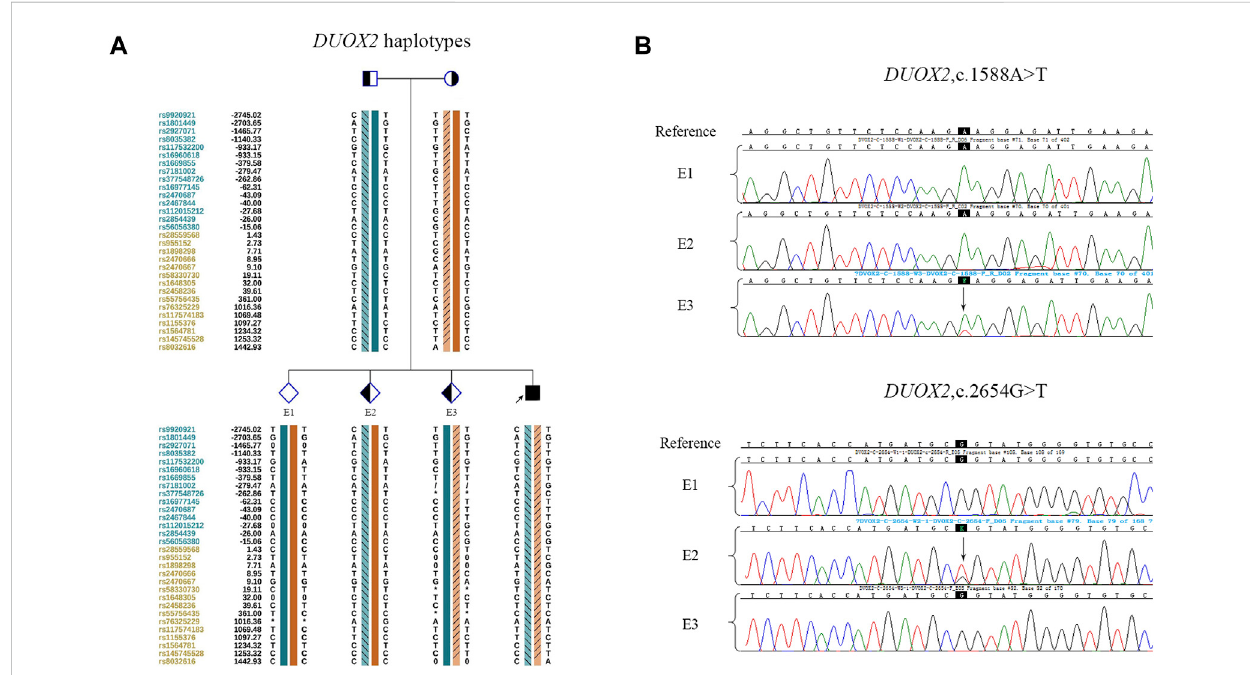
FIGURE 2 Linkage analysis and mutation detection in embryos. (A) Haplotypes around DUOX2 of the family members and embryos. Diamonds indicate embryos, and the interpretation of other symbols and bars is explained in the legend of Figure 1B. E1 inherited both wild-type haplotypes from parents. E2 inherited the paternal mutation and maternal wild-type haplotype. E3 inherited the paternal wild-type haplotype and maternal mutation. (B) The mutations in embryos were identi fi ed by Sanger sequencing. The results were consistent with those of the SNP-based linkage